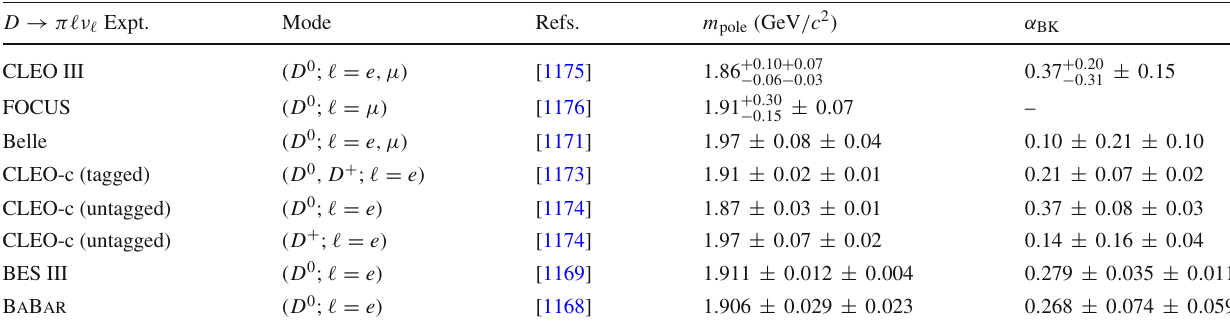
Table 272 Results for m pole and α BK from various experiments for D 0 → π − (cid:12) + ν and D + → π 0 (cid:12) + ν decays D → π(cid:12)ν (cid:12)